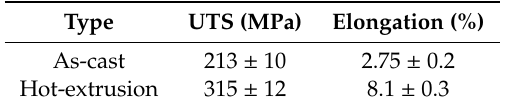
Table 2. The mechanical properties of the AM50Gd magnesium